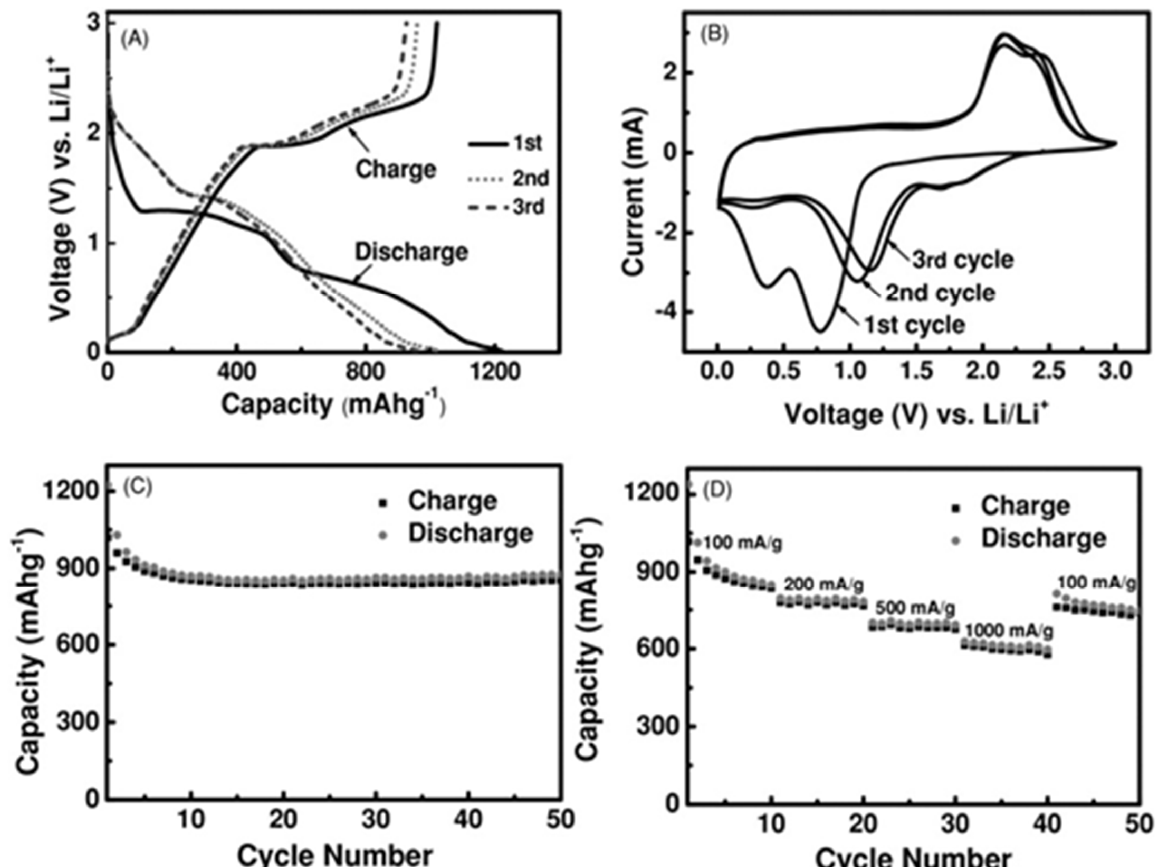
Figure 10. ( A ) Charge/discharge voltage profiles of MoS 2 /3DGN composite at the 1st, 2nd, and 3rd cycles. ( B ) Representative cyclic voltammograms of MoS 2 /3DGN composite at the first 3 cycles at a scan rate of 0.5 mV s − 1 between 0.01 V and 3 V. ( C ) Cycling performance of MoS 2 /3DGN composites at a current density of 100 mA g − 1 . ( D ) Cycling stability of MoS 2 /3DGN composite at various current densities. Reproduced with permission of ref. [121]. Copyright 2013. WILEY-VCH Verlag GmbH & Co. KGaA, Weinheim.